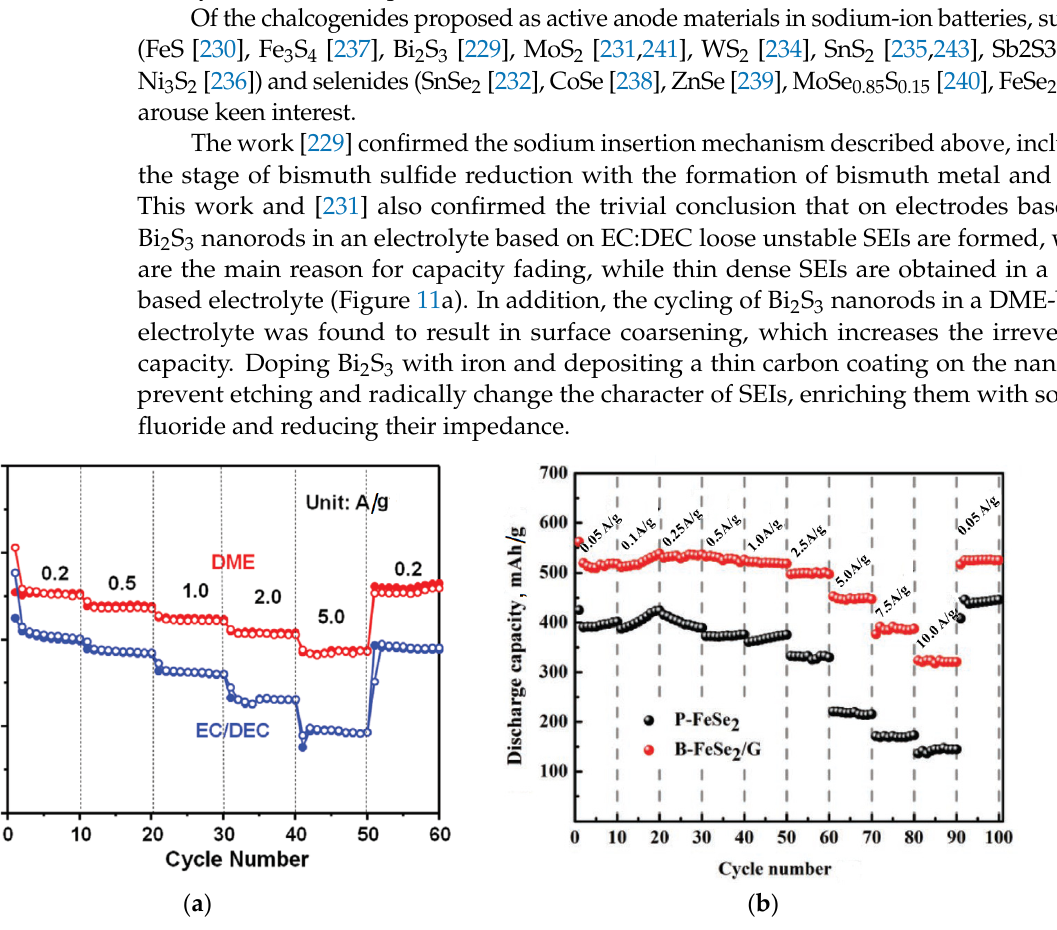
Figure 11. ( a ) Rate performance of MoS 2 @C in DME and EC/DEC electrolytes. (Reprinted with permission from [231]. Copyright 2020, Wiley Online Library). ( b ) The rate capability of P-FeSe 2 and B-FeSe 2 /G at various current densities. (Reprinted with permission from [270]. Copyright 2019, Wiley Online Library).